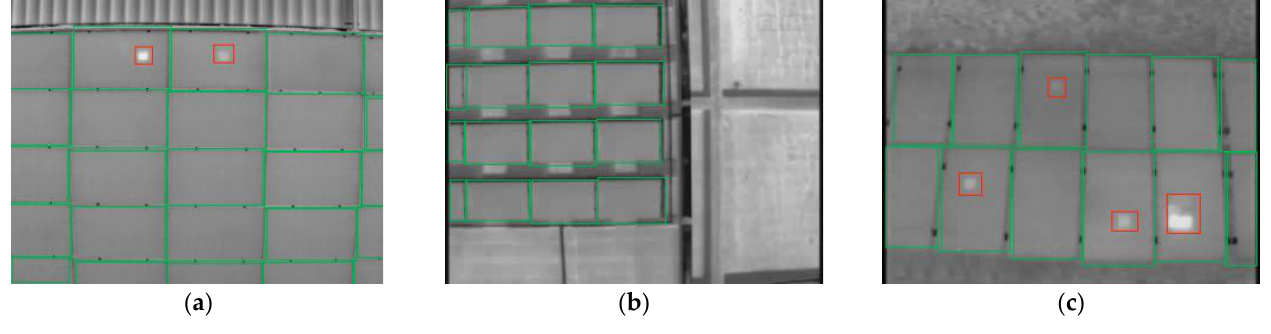
Figure 7. Pictures of the infrared photovoltaic panels after manual annotation: ( a ) two hot spots and 20 photovoltaic panels; ( b ) 16 photovoltaic panels; ( c ) 12 photovoltaic panels and four hot spots.